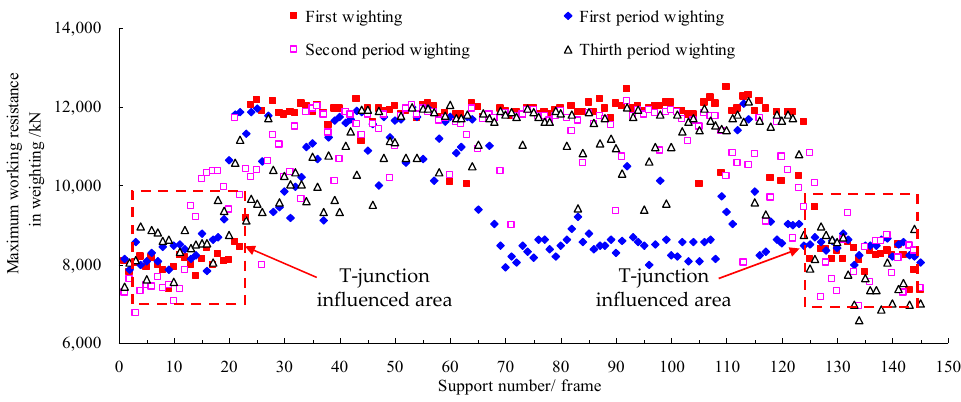
Figure 12. Working resistance at different weighting times.